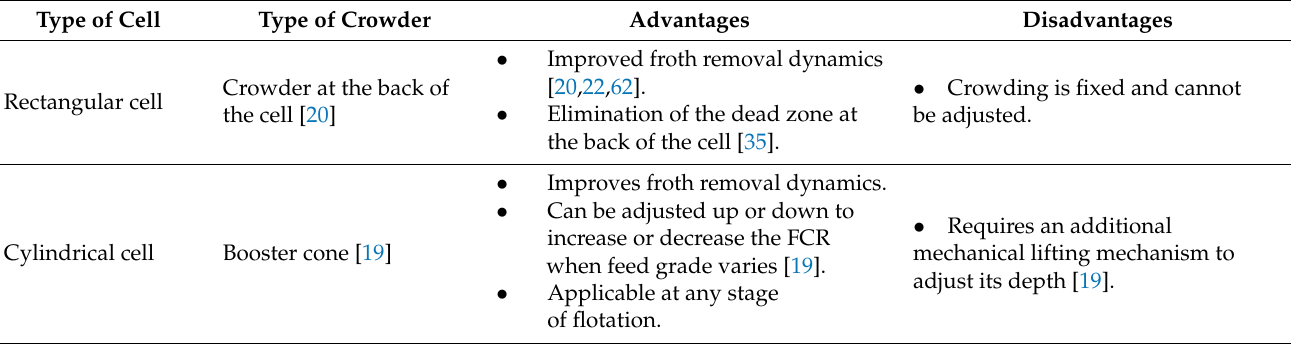
Table 4. Types of crowders used in